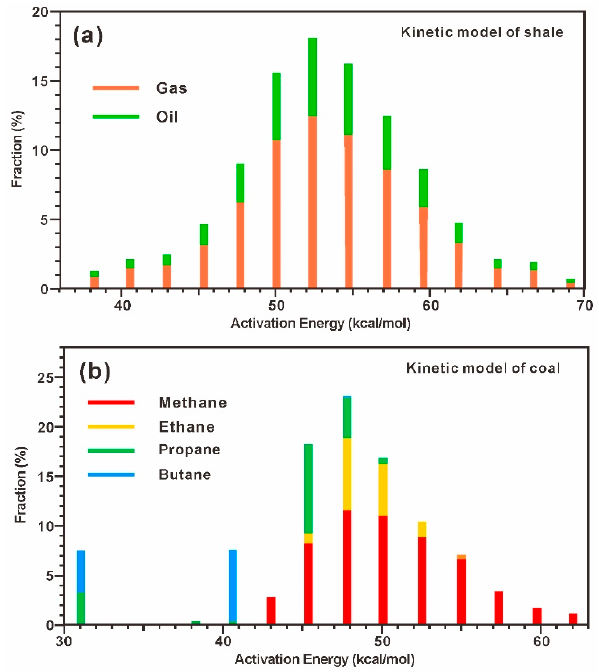
Figure 6. Kinetic models of the source rocks of the Changling Depression in this study. ( a ) Kinetic model of the shale based on the Burnham TIII model [69]; ( b ) kinetic model of the coal seam based on the Pepper and Corvi TIIIH(DE) model